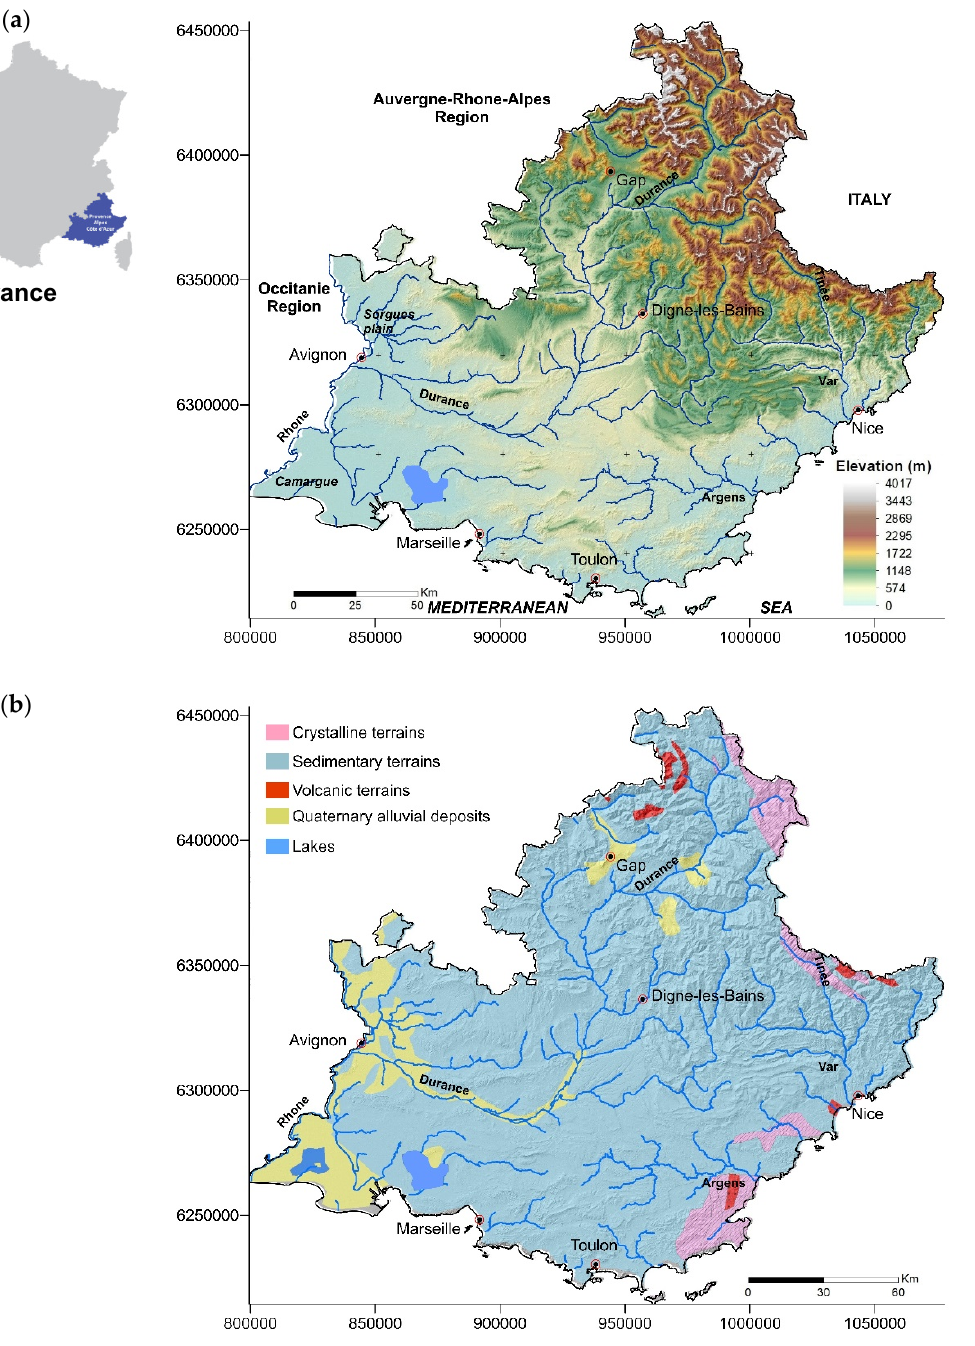
Figure 1. Location of the PACA region, elevation ( a ) and main rock types ( b ) of the PACA Region. Coordinates are lambert 93.